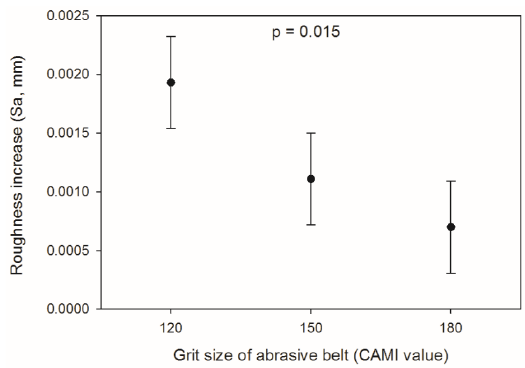
Figure 9. Effect of grit size of abrasive belts on the grain raising of maple veneer-faced panels